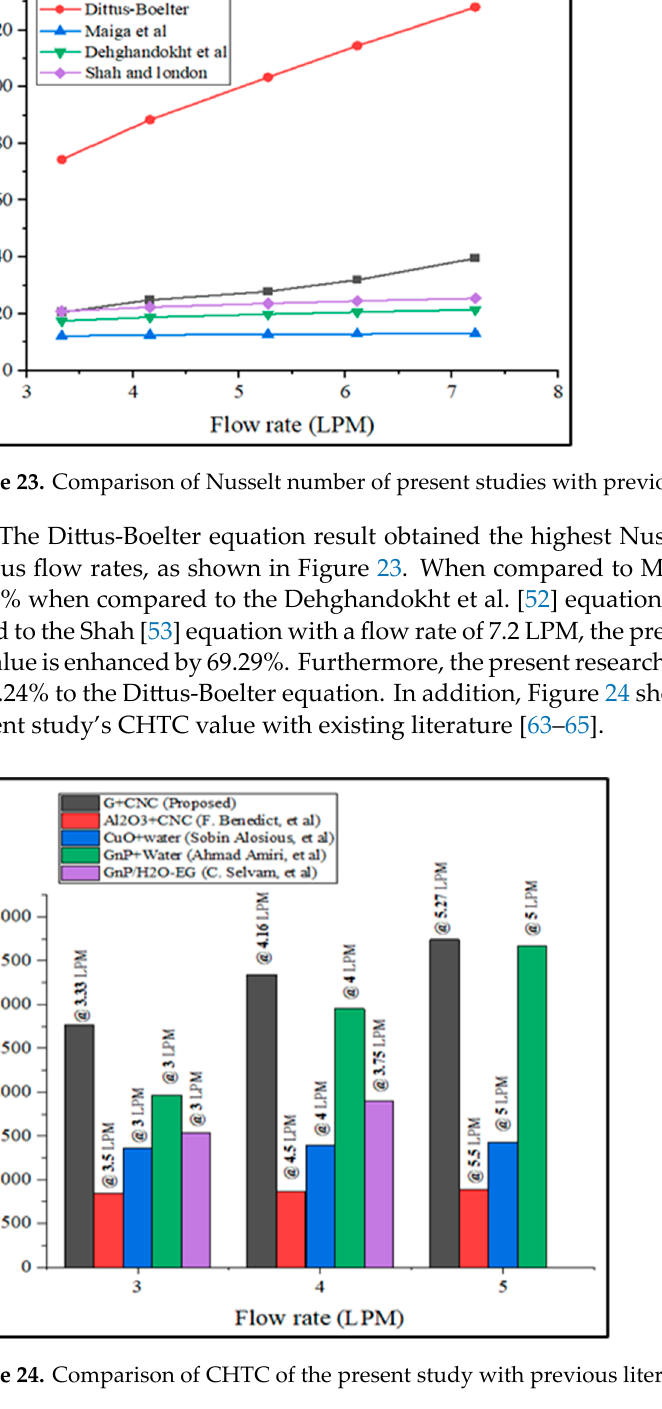
Figure 25. Comparison of pressure drop of the present study with previous literatures [67,68]. In comparison to earlier literature, the current investigation shows a better perfor- mance in terms of pressure drop (Figure 25). For the comparison process, flow rates of 3.5, 4.5, and 5.5 LPM are used, and literature results are obtained from the author [68]. There is no data on thw pressure drop because this study is not conducted at 3.5 LPM. When compared to [67], an identical experimental setup, the pressure drop is 92.75% lower at 5.5 LPM, and 98.67% lower when compared to the author [68] data. The experimental